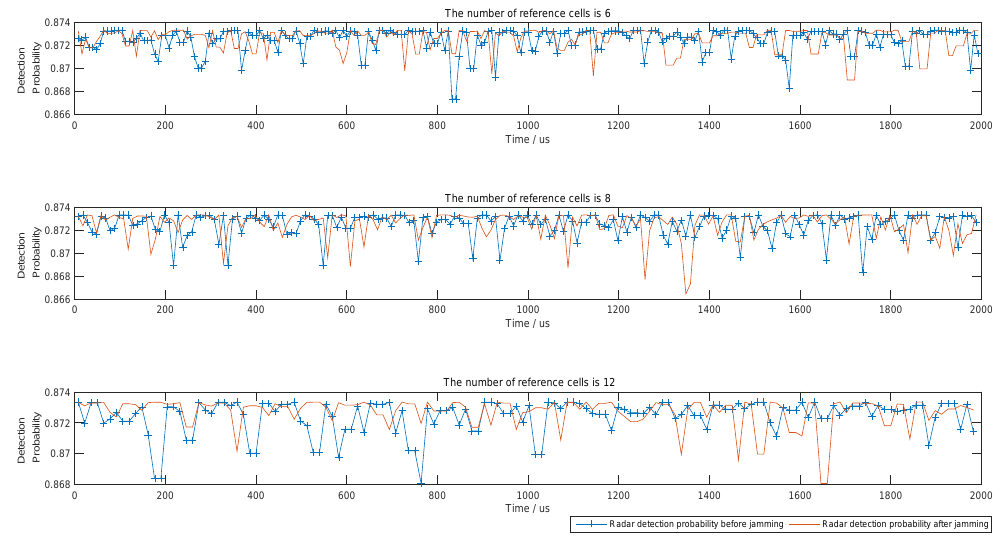
Figure 6. Detection probability of airborne radar after